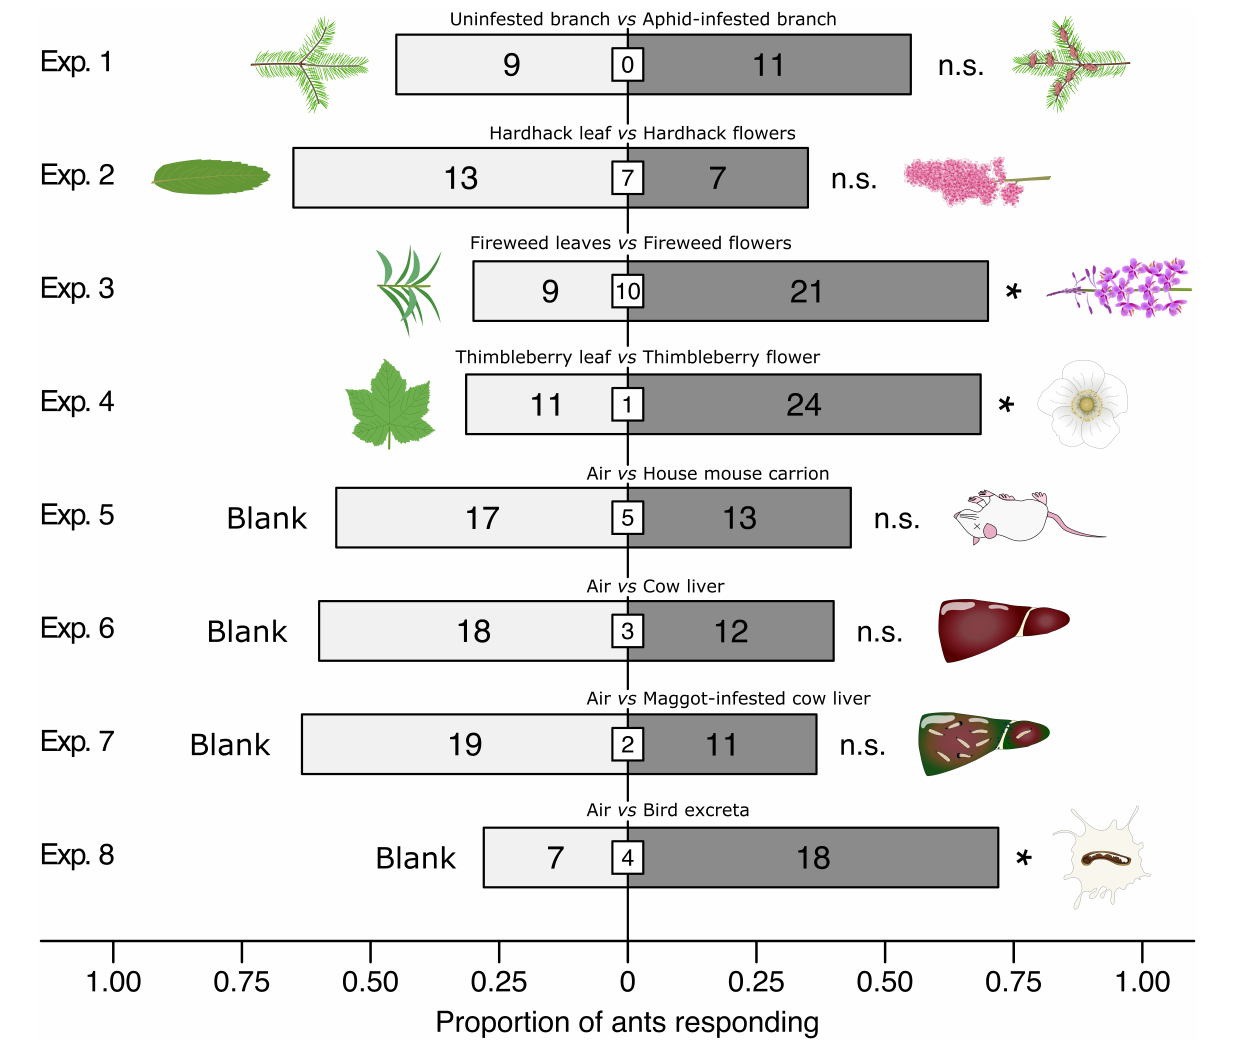
FIGURE 2 | Effect of test stimuli on responses of Camponotus modoc worker ants in Y-tube olfactometer ( Figure 1 ) experiments 1–8, each with 20–35 responding ants. Treatment and control stimuli are indicated above bars and illustrated next to bars. Numbers within bars indicate the number of ants responding to test stimuli and numbers in white inset boxes indicate the number of non-responding ants. An asterisk denotes a significant preference for a test stimulus (Pearson’s χ 2 tests: p < 0.05; n. s., not